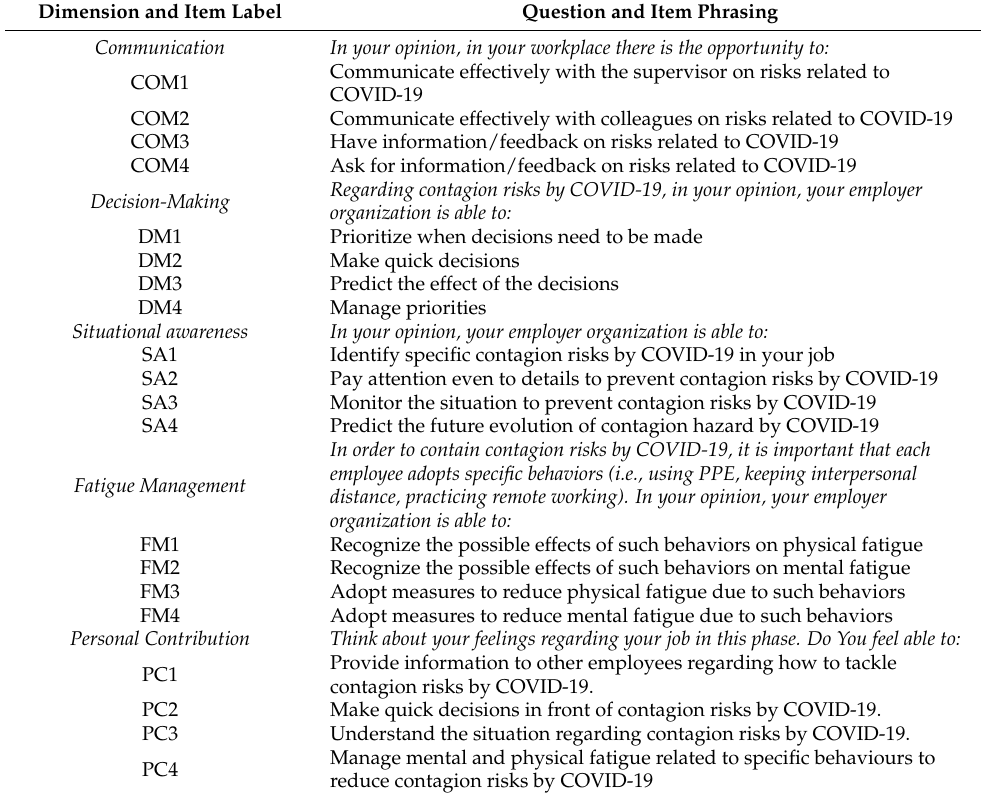
Table 1. The SAPH@W